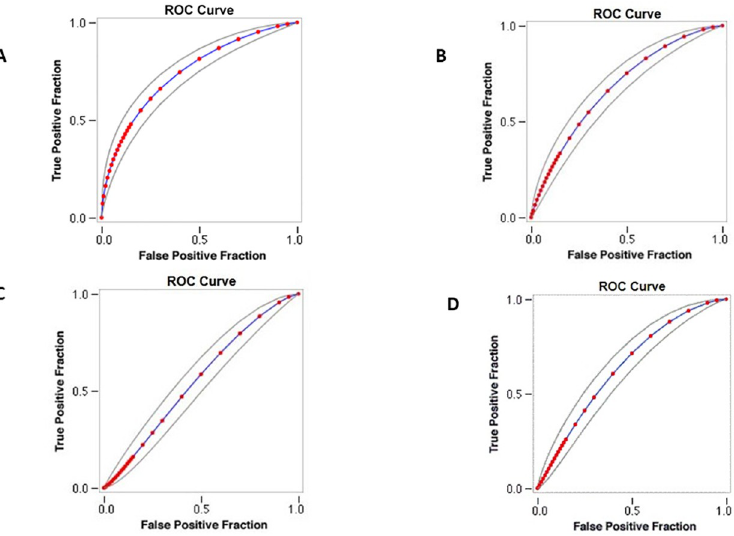
Fig 2. Sensitivity analysis with receiver operating characteristics curve. (A) Model with postprandial glucose excursion. (B) Model without postprandial glucose excursion. (C) Model with plasma remnant cholesterol. (D) Model with stratification by ratio of triglycerides and remnant